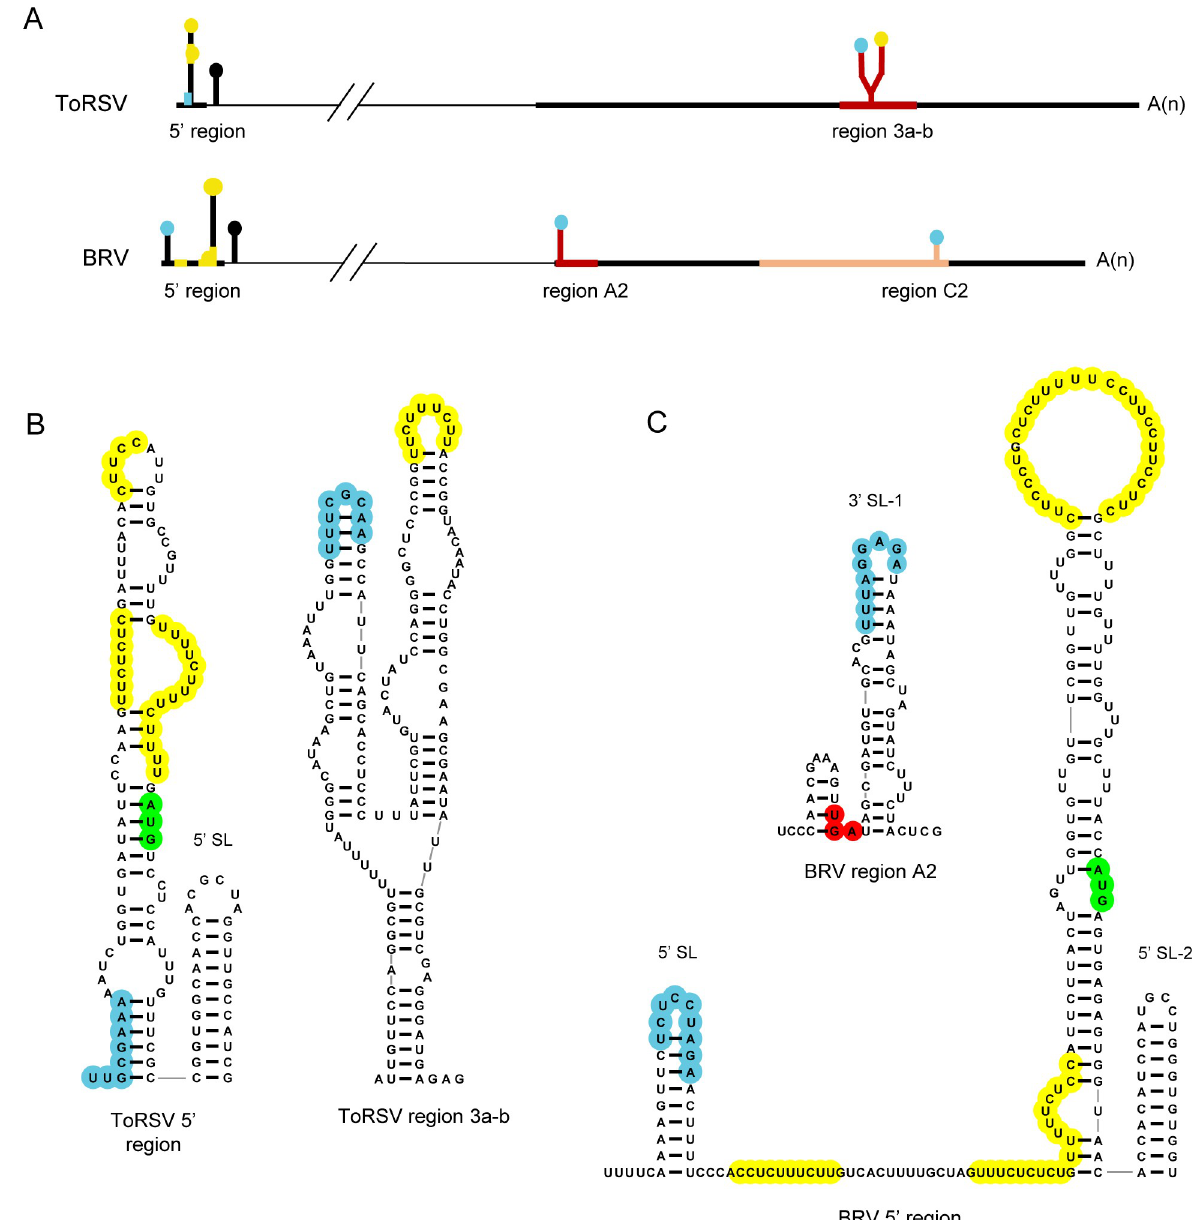
Fig 10. Comparison of identified translation-enhancing elements and predicted secondary structures in BRV and ToRSV-Rasp1 RNA2s. (A) Schematic representation of the location of translation-enhancing elements. The RNA2s of ToRSV and BRV are shown with the coding region of the polyprotein represented by thin horizontal black lines and the UTRs by thicker horizontal black lines. Regions in the 3’ UTRs identified as playing a critical role in translation are shown in red. A region of the BRV 3’ UTR identified as playing a modest role in translation is shown in orange. (B) Predicted secondary structures of the ToRSV-Rasp1 RNA2 5’ region and 3’ UTR region 3a-b. Structures discussed in the text are shown. For a more detailed representation of ToRSV RNAs features please refer to Figs 9 and S4 . (C) Predicted secondary structures of the BRV RNA2 5’ region and 3’ UTR region A2. Structures discussed in the text are shown. For a more detailed representation of BRV RNA2 features (including a predicted stem-loop in region C2), please refer to S6 Fig . For all panels, identified regions of sequence complementarities between the 5’ and 3’ UTRs are shown in light blue. Polypyrimidine stretches are shown in yellow. The first AUG and the stop codon are highlighted in green and red, respectively.